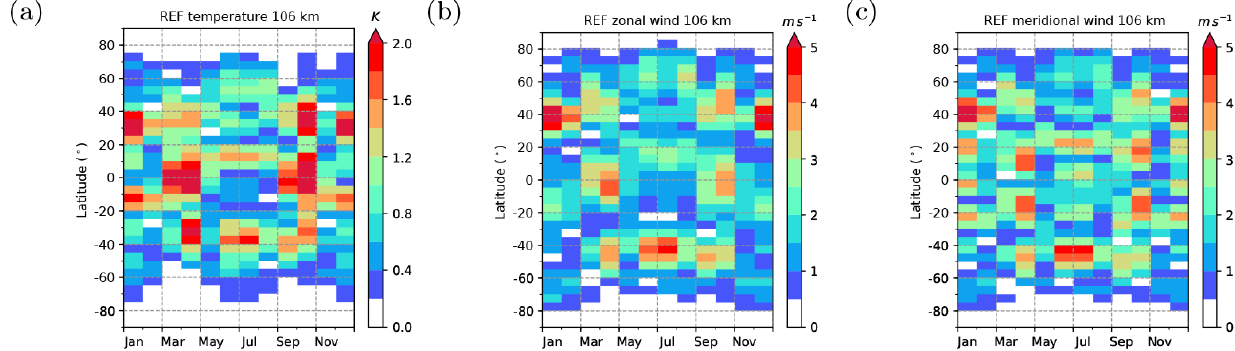
Figure 7. REF monthly mean TDT amplitudes at an altitude of ≈ 106km. From left to right: (a) temperature, (b) zonal wind component, (c) meridional wind